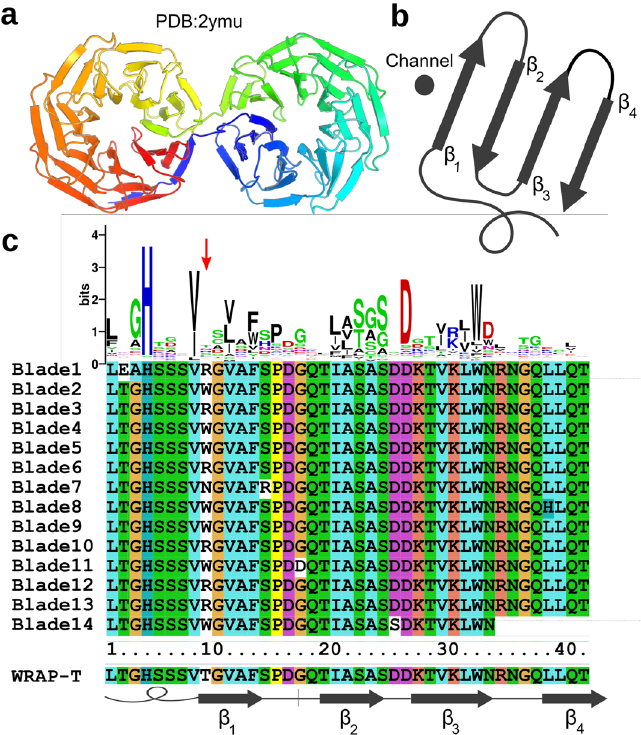
Figure 1. Design of the WRAP-T repeat. The structure 2ymu, the protein consists of 14 nearly identical WD40 repeats, folded into two seven-bladed β -propellers ( a ). A schematic representation of a single WD40 repeat. The repeat folds in four β -strands numbered form one to four from the inside of the cavity to the outside of the cavity ( b ). Sequence alignment of all 14 repeats of 2ymu, the sequence logo on top was constructed based on 7,142 sequences classified in the PROSITE database as WD40 repeats. The sequence of WRAP-T is shown on the bottom accompanied by a diagram showing the location of the β -strands ( c ). Panel ( a ) was created with PyMOL 23